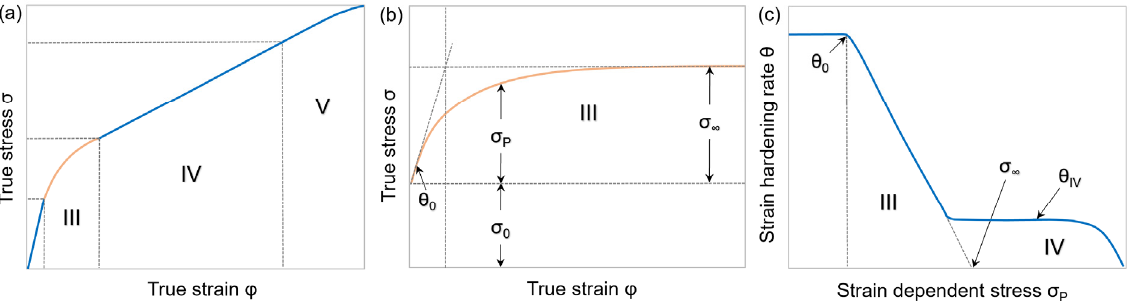
Figure 1. Schematic classification of polycrystal strain hardening behavior into separate stages. ( a ) Entire stress–strain curve with highlighted stage III; ( b ) stage III detail view of flow curve adapted from [43]; ( c ) strain hardening rate θ versus strain-dependent stress σ P (Kocks-plot) adapted from [1]. In general, any stress–strain curve (stage III) is thus adequately represented by the three parameters σ 0 , σ ∞ , and θ 0 . With σ = σ P + σ 0 , the dislocation density can then